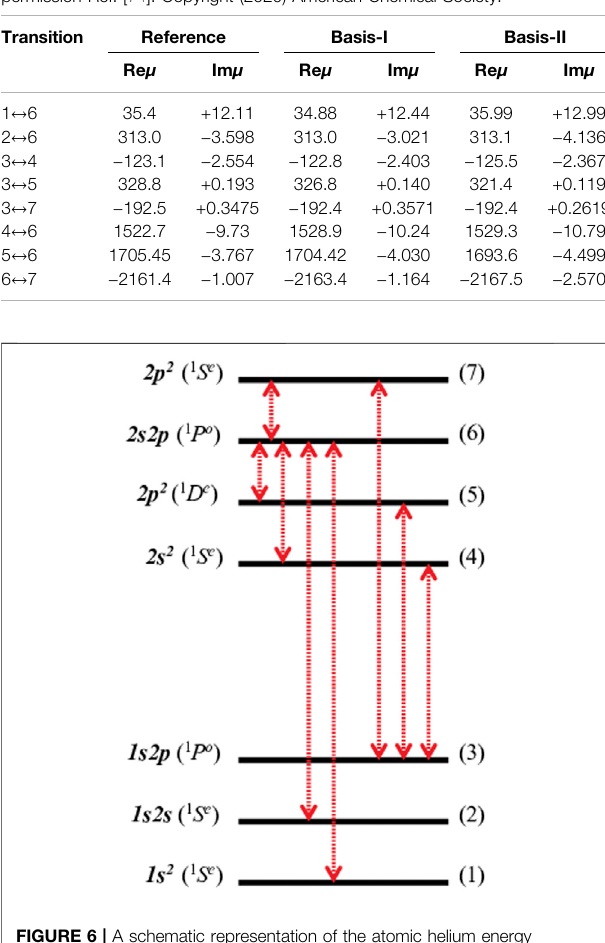
FIGURE 6 | A schematic representation of the atomic helium energy levels. The singly and doubly excited states correspond to bound and resonancestates, respectively. There arethree bound states (atthebottom of the fi gure) and four resonance states (at the top). The left-hand side shows thespectroscopicatomictermsymbols,whichareassociatedwiththe index lables (shown on the right-hand side). The red double arrows represent the dipole allowed transitions, these eight complex dipoles are presented in Table 2 . Reprinted (adapted) with permission Ref. [74]. Copyright (2020) American Chemical